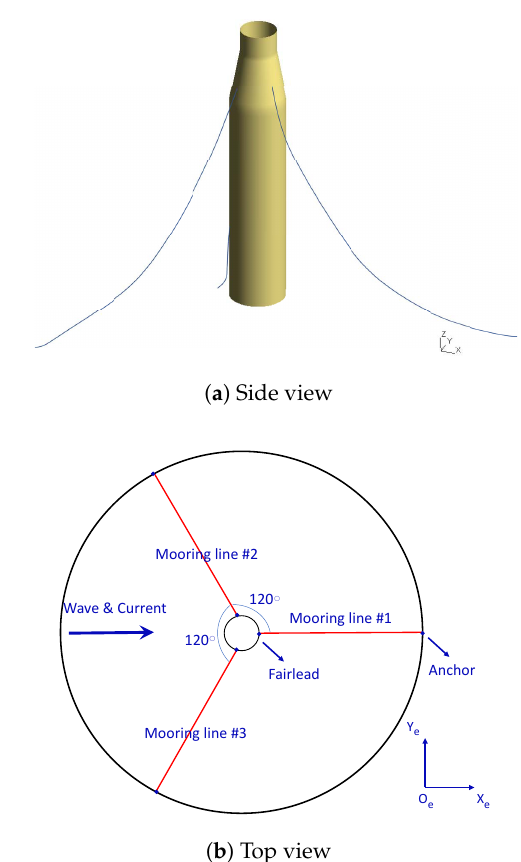
Figure 11. Sketch of catenary mooring system of the 6 MW spar-type